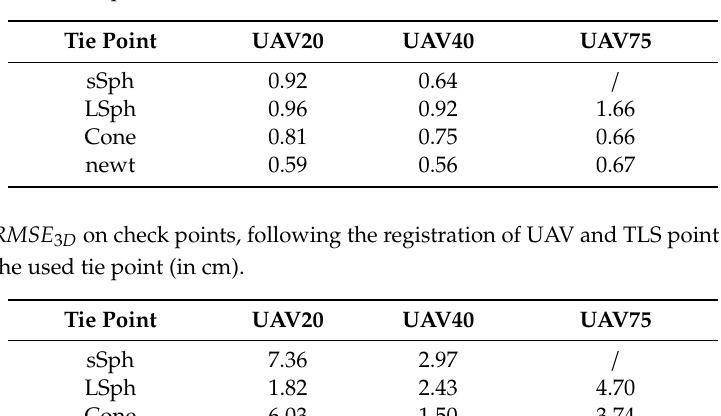
Figure 14. The RMSE 3 D on check points, following the registration of UAV and TLS point clouds, taking into account the used tie point, given in cm. “Georef” represents the RMSE prior to the registration of the TLS and UAV point clouds.